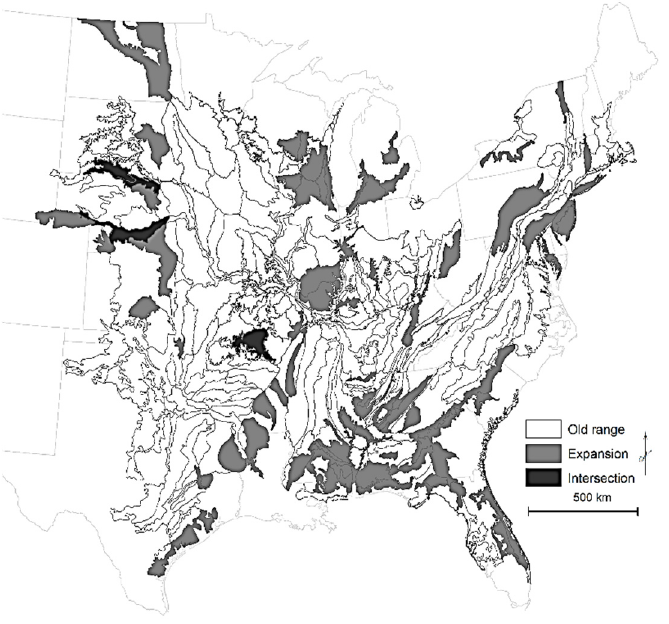
Figure 2. Recent expansion of presence range (composition ≥ 0.5%; outlined and shaded gray) of eastern redcedar. Subsections shaded black indicate areas of recent intersection with presence range of western Juniperus species (the most northern subsections are connected). Table 2. Species that decreased by ≥ 5% composition where Juniperus species have increased by ≥ 5%